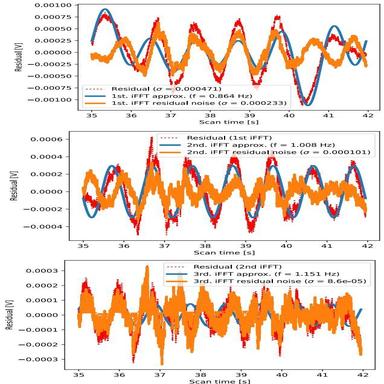
Post-processing of the background noise using inverse FFT for the Scenario C with 75 % air + 25 % CO2.